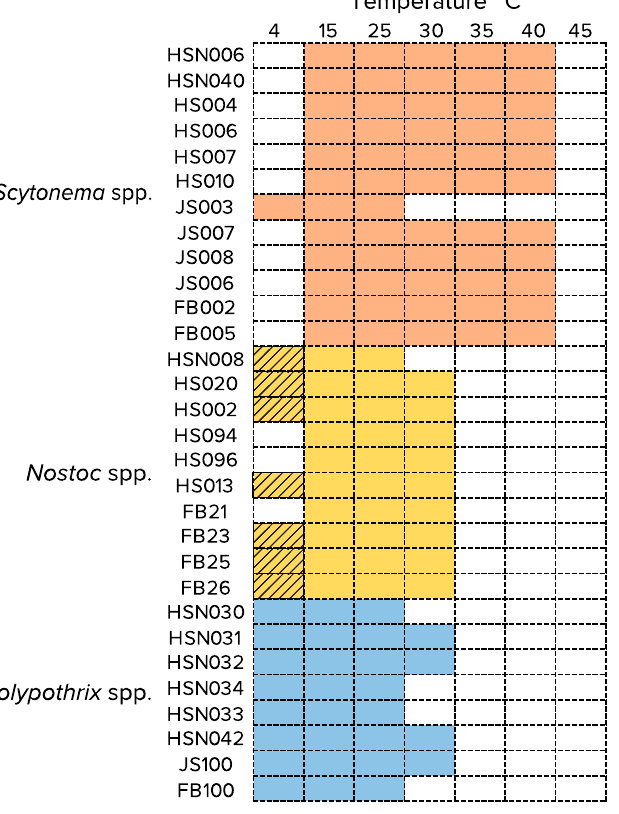
Figure 2. Temperature range at which the studied cyanobacterial strains can grow or survive under diazotrophic conditions. Colored rectangles indicate positive growth; hatched rectangles indicate stasis (no growth, but no obvious deterioration).